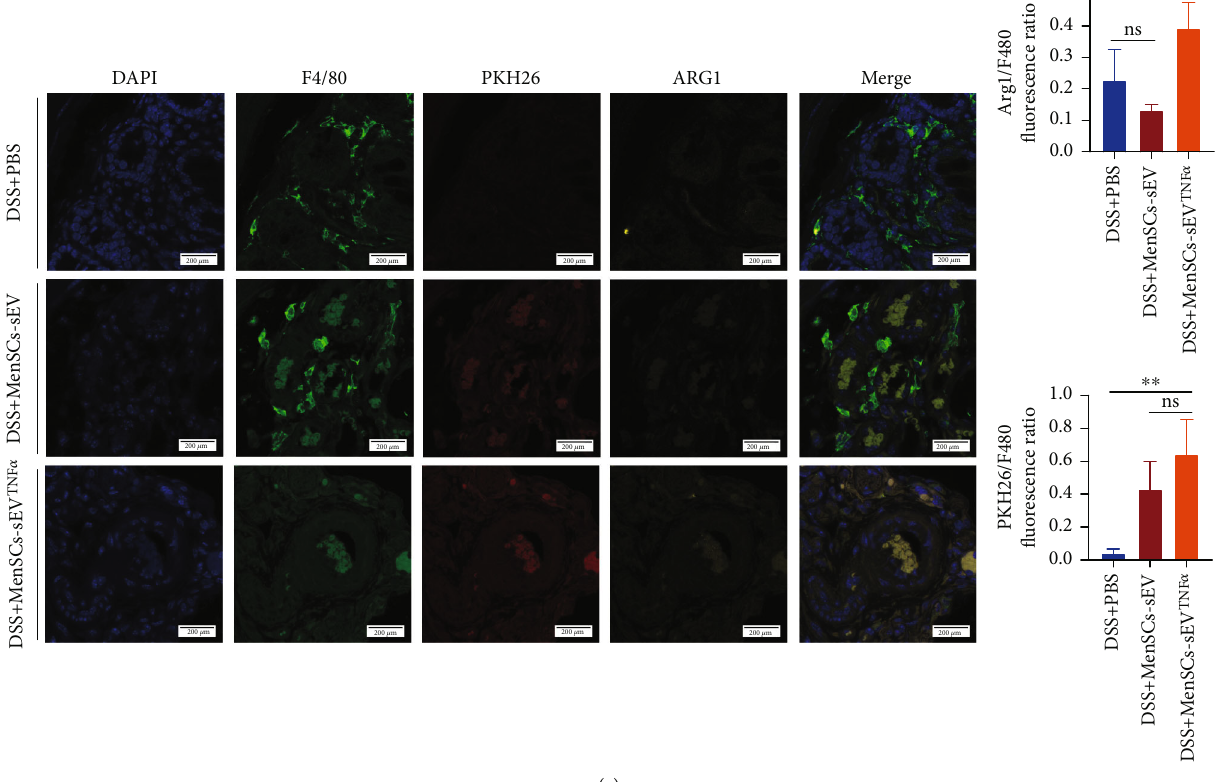
Figure 6: MenSCs-sEV TNF- α can increase the proportion of M2 macrophages in vivo. (a) The level of Arg1 and iNOS in the colon of mice was measured by ELISA. (b) Flow cytometry showed the proportion of PKH26+ cells (absorbing PKH26-labeled MenSCs-sEV TNF- α ) and M2 macrophages in colonic lamina propria mononuclear cells. (c) PKH26-labeled small EVs were intraperitoneally injected into mice, and the immuno fl uorescence staining of DAPI, F4/80, and Arg1 in the colon of mice was shown in the confocal